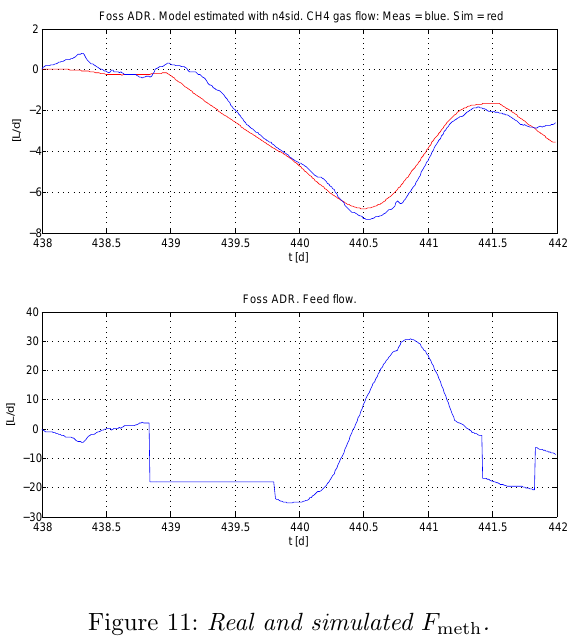
Figure 11: Real and simulated F meth .